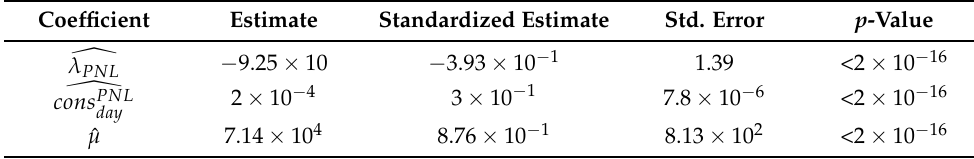
Table 9. Regression analysis coefficients result for pork products without